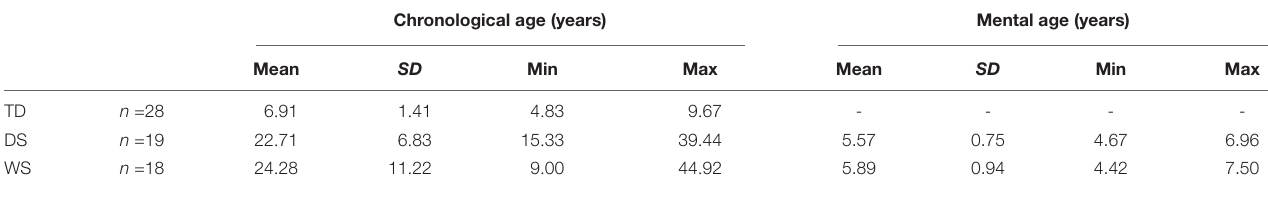
TABLE 1 | Demographics of participants at the beginning of the